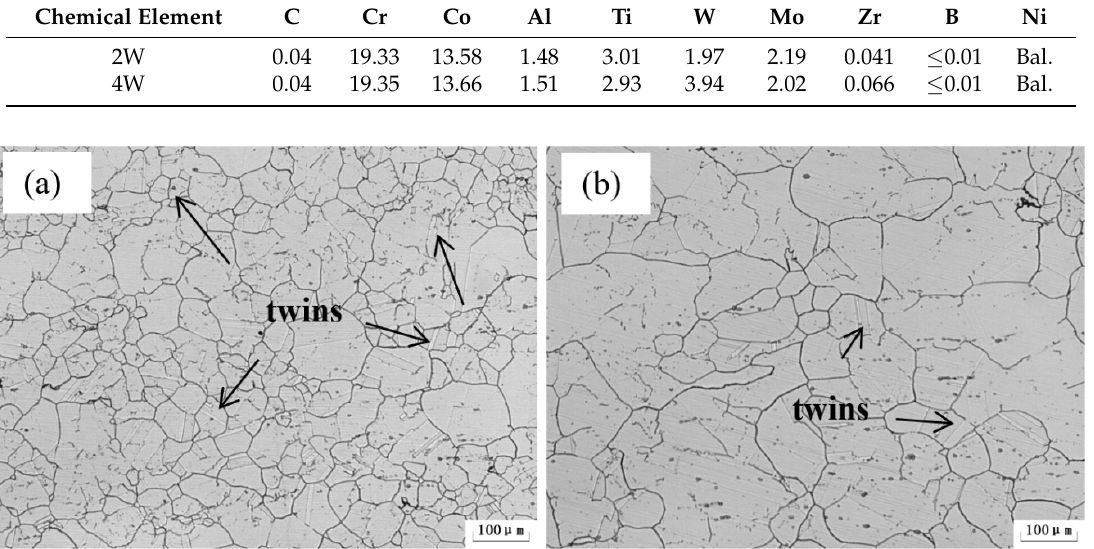
Table 1. Mass percentage of the GY200 alloys.